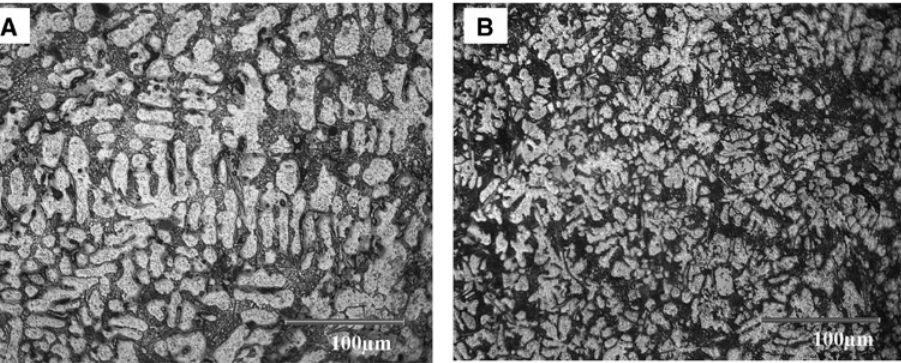
composite processed at 10 min AT and 20 min 2